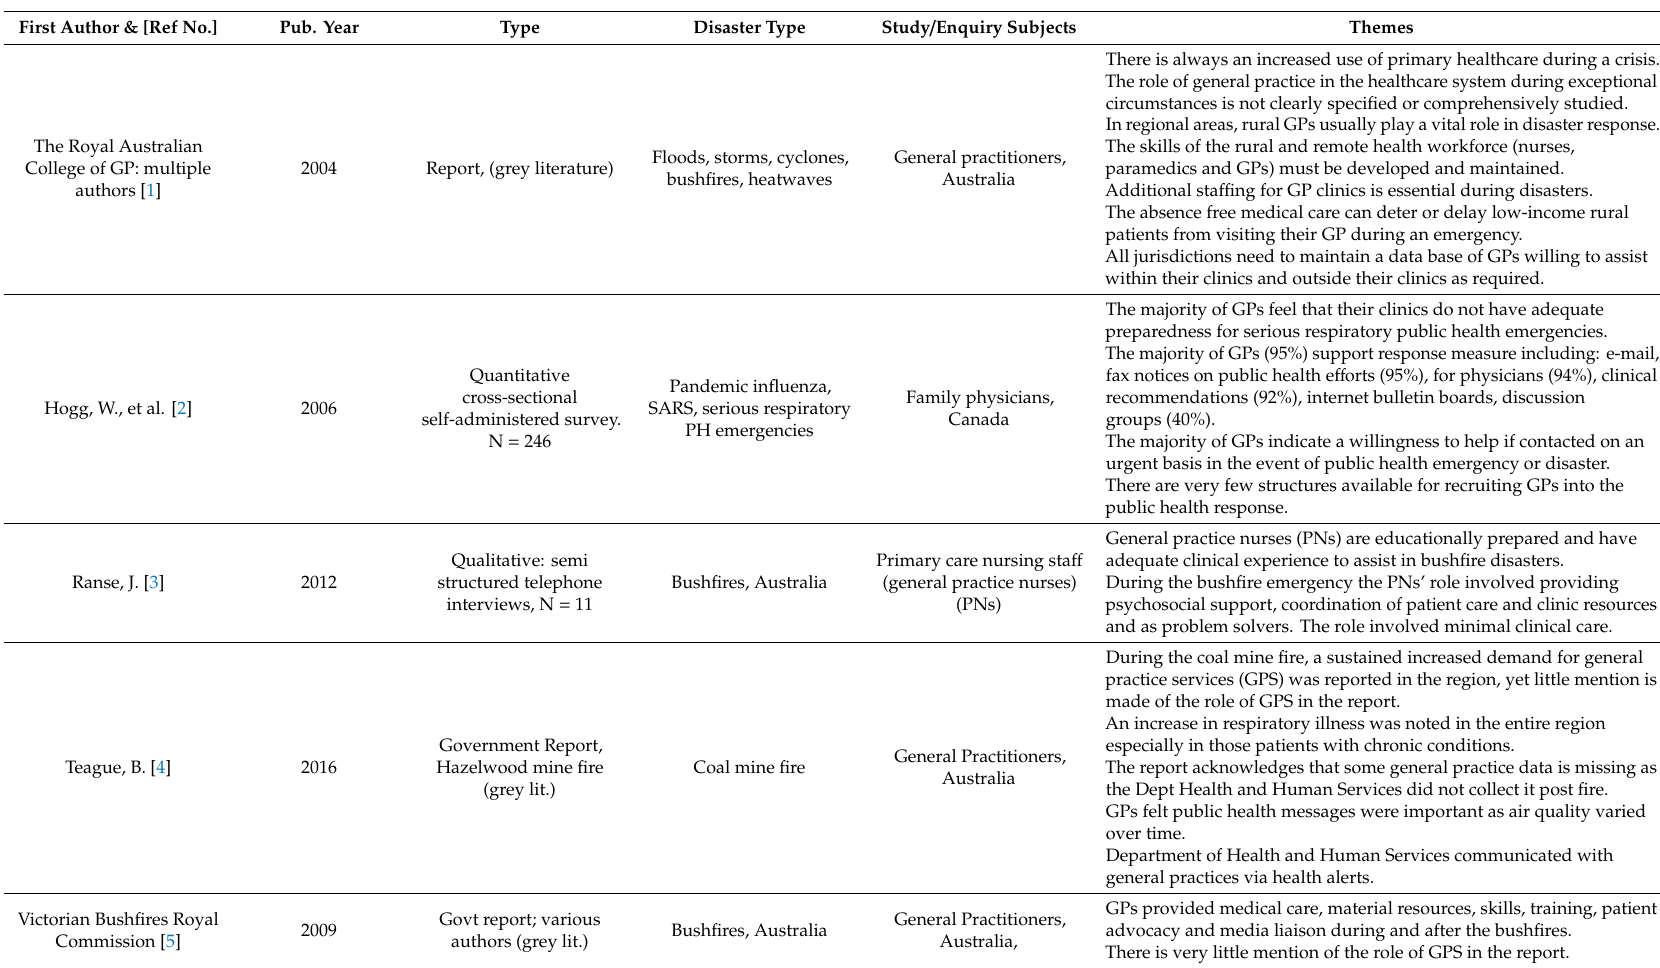
Table 1. Characteristics of included